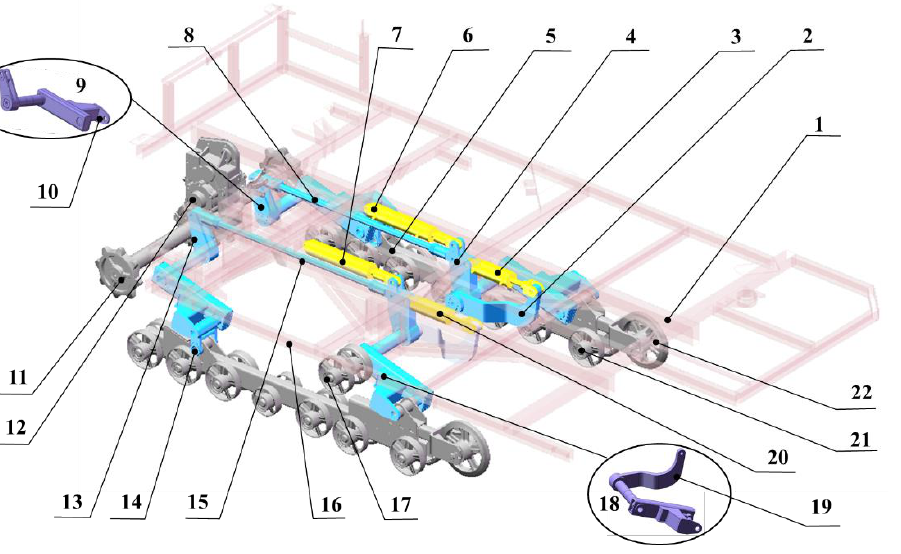
Figure 2. Detailed structure of the attitude adjustment mechanism: (1) chassis frame, (2) right rear oscillating arm assembly, (3) right rear hydraulic cylinder, (4) right rear pivot arm, (5) right walking beam, (6) right front hydraulic cylinder, (7) left front hydraulic cylinder, (8) right connecting rod, (9) right front oscillating arm assembly, (10) right connecting arm, (11) driving wheel, (12) gearbox, (13) left front oscillating arm assembly, (14) left connecting arm, (15) left connecting rod, (16) left walking beam, (17) track roller, (18) left rear oscillating arm assembly, (19) left rear pivot arm, (20) left rear hydraulic cylinder, (21) thrust wheel, (22) tensioner.